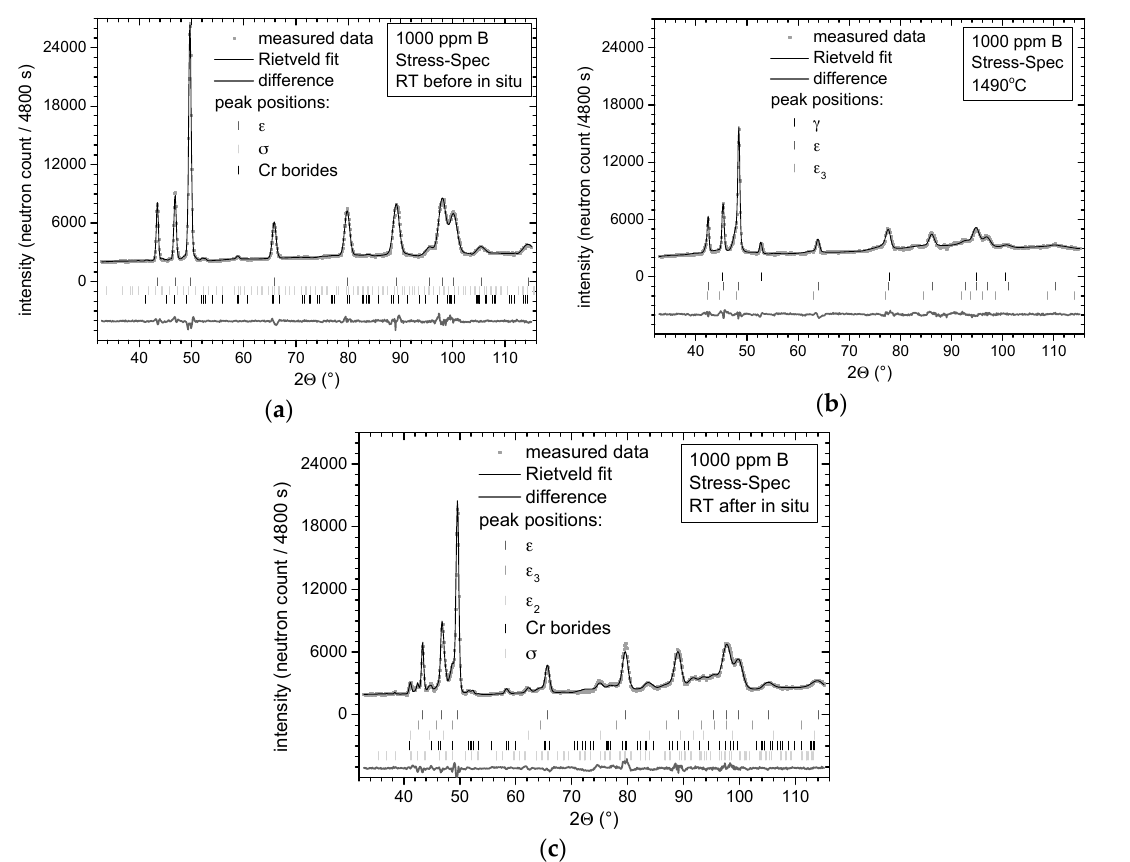
Figure 4. Diffractograms for 1000 ppm B sample ( a ) at RT before in-situ cycle, ( b ) at 1490 °C and ( c ) at RT after in-situ cycle.